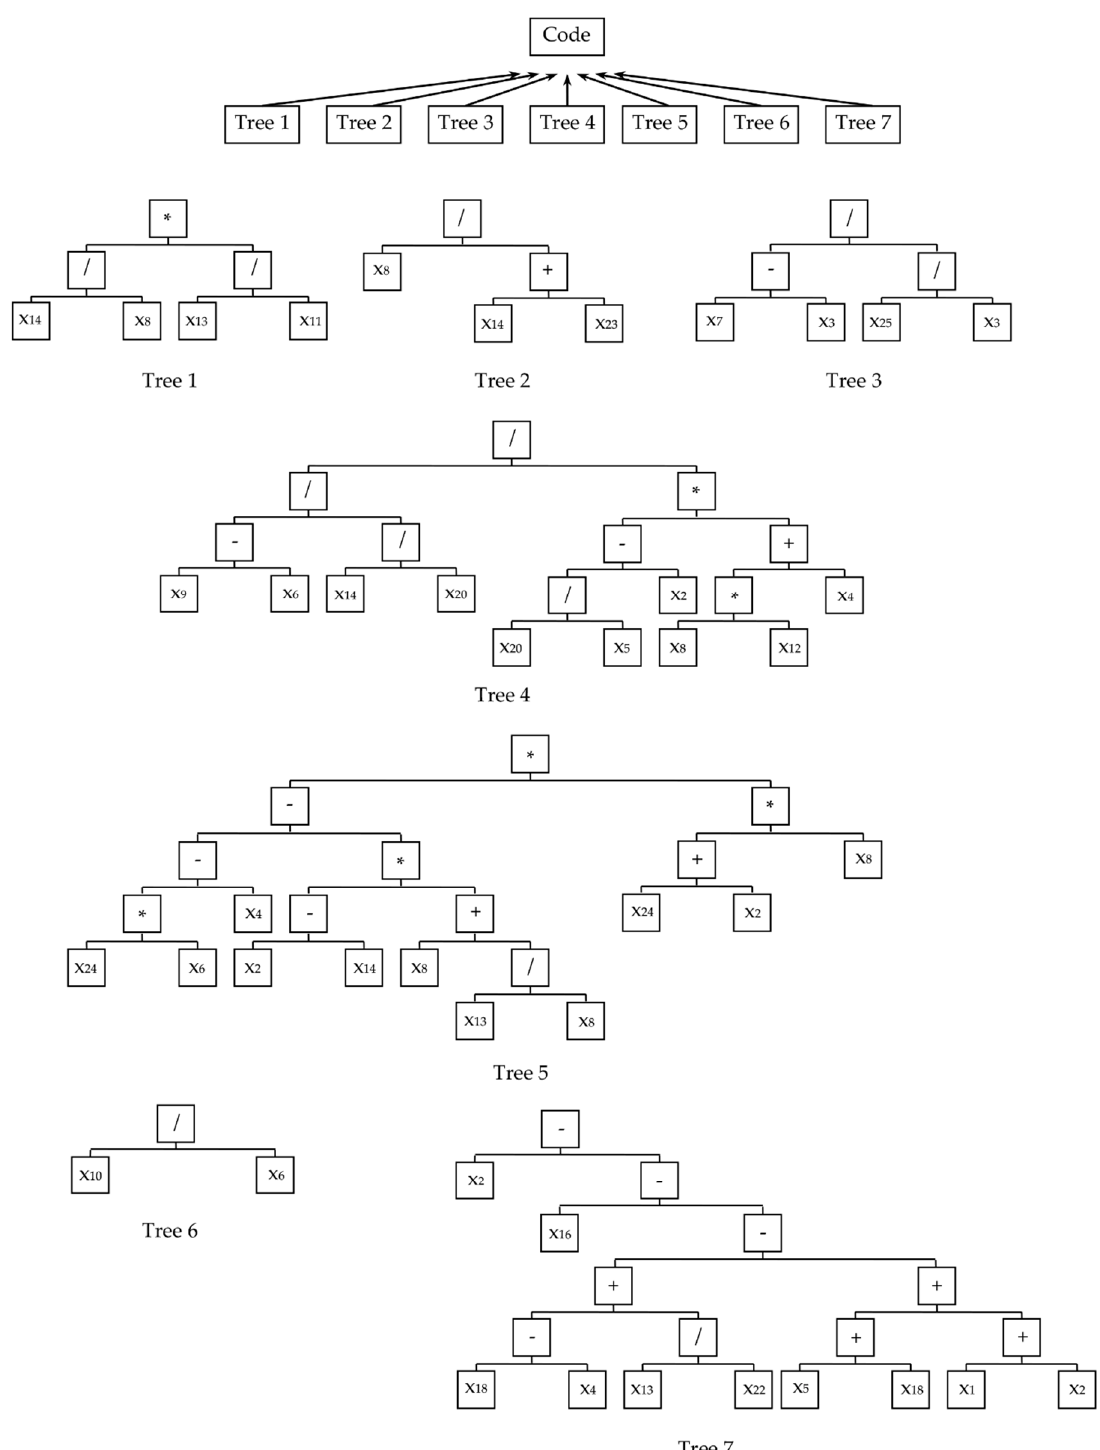
Figure 15. Best Model of ABCP-Descriptor for DS-Broadtz. Table 5. Equations of Subtrees of Best Model of ABCP-Descriptor for DS-Broadtz.